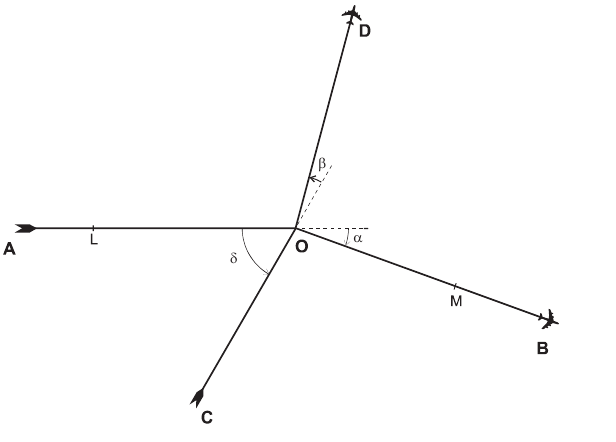
Figure 2. Intersection − angle Figure 3. Intersection – duration